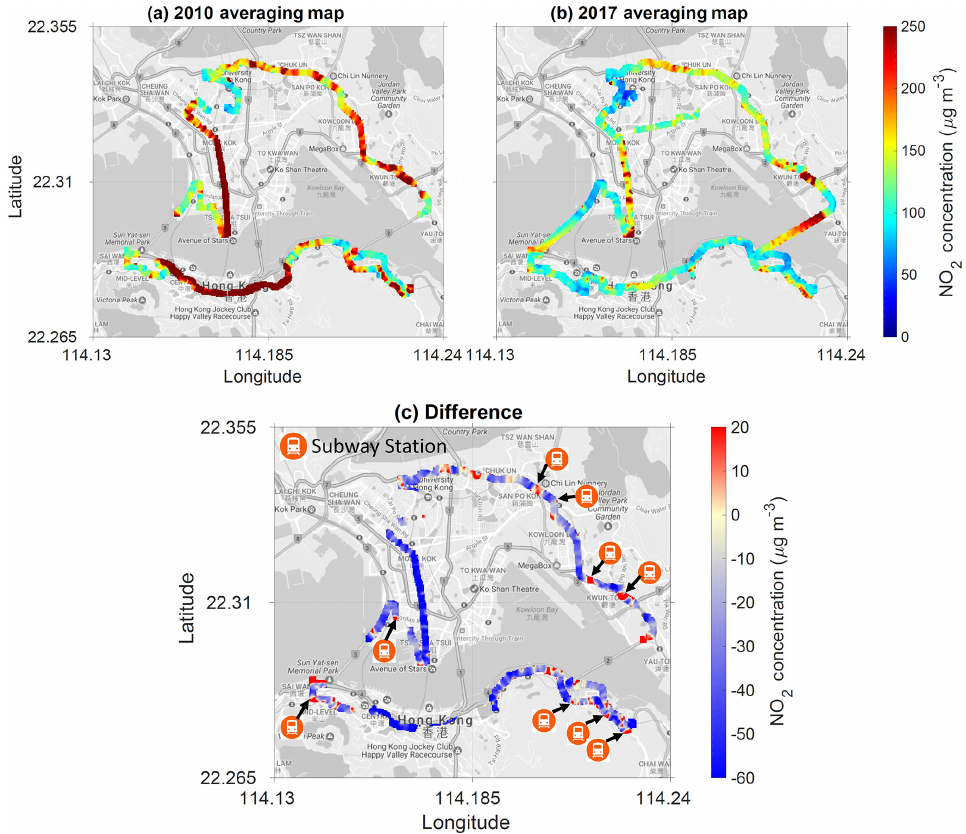
Figure 8. Averaged on-road NO 2 concentrations measured along the standard route during (a) December 2010 and (b) March 2017. Panel (c) shows the relative differences between 2010 and 2017. The markers indicate the location of metro stations. Measurements taken during morning rush hours, noontime and evening rush hours are weighted equally in the